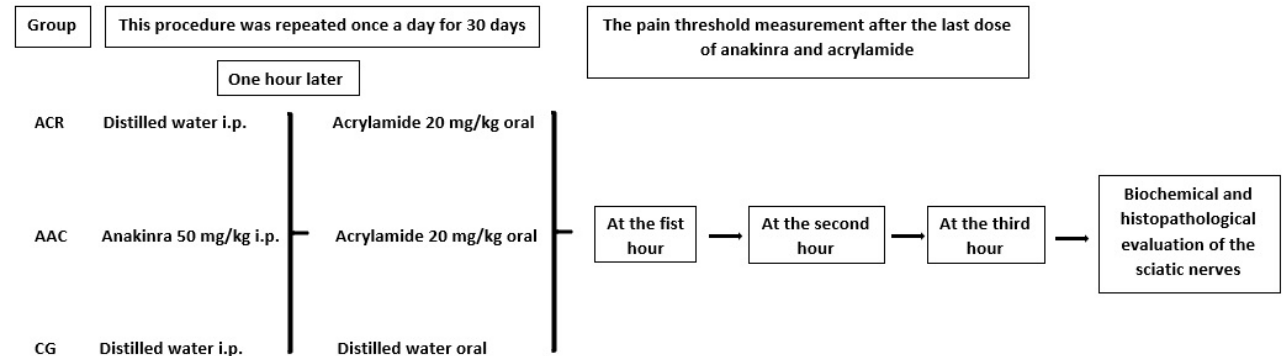
FIGURE 1 - Schematic description of the experimental protocol. CG control group, ACR acrylamide-treated group, AAC anakinra + acrylamide-treated